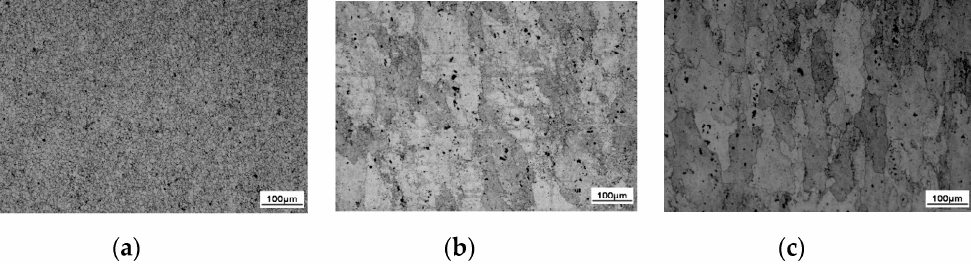
Figure 8. Metallographs of di ff erent zones in the aluminum alloy FSW joints: ( a ) WNZ; ( b ) TMAZ; Figure 8. Metallographs of different zones in the aluminum alloy FSW joints: ( a ) WNZ; ( b ) TMAZ; ( c ) ( c ) HAZ. Figure 8. Metallographs of different zones in the aluminum alloy FSW joints: ( a ) WNZ; ( b ) TMAZ; ( c ) HAZ. Figure 8. Metallographs of different zones in the aluminum alloy FSW joints: ( a ) WNZ; ( b ) TMAZ; ( c ) HAZ.